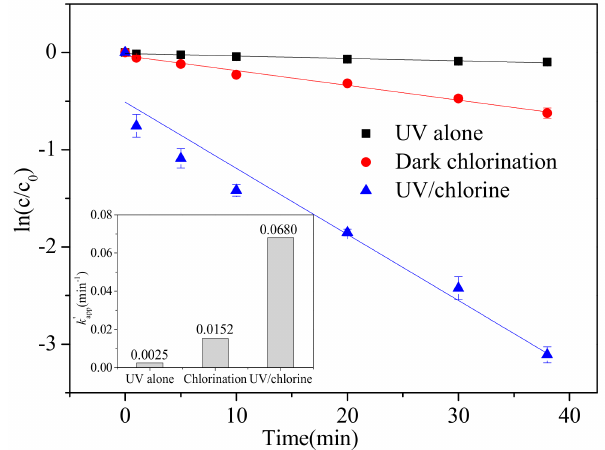
Figure 1. Amlodipine (AML) removal by UV alone, dark chlorination, and the UV / chlorine process ([AML] 0 = 10 µ M, [chlorine] 0 = 20 µ M, UV intensity = 1000 µ W · cm − 2 , pH = 7).